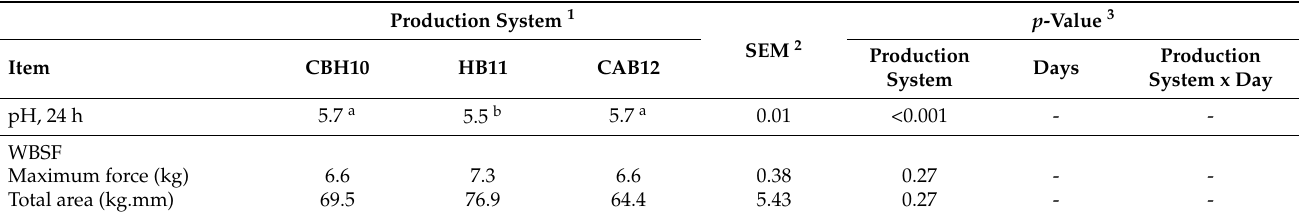
Table 4. Meat pH, shear force, intramuscular fat and evolution of the shelf-life parameters (instru- mental color, color perception, and purchase decision) over the time in MAP of meat of animals raised in different Mediterranean beef fattening